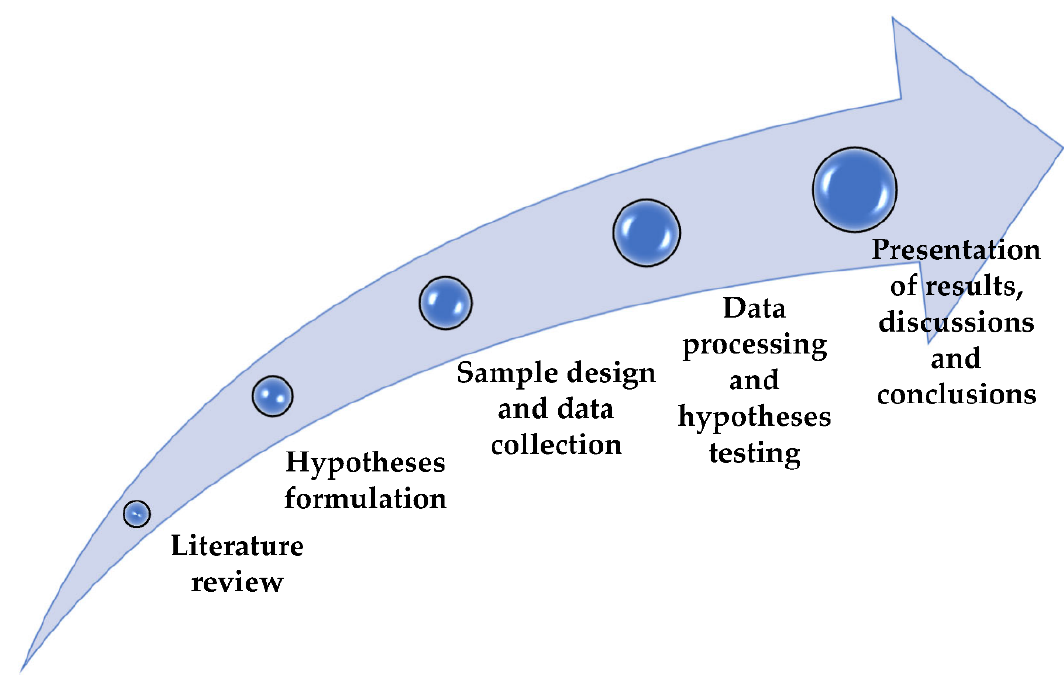
Figure 1. Research process. Source: own construction.